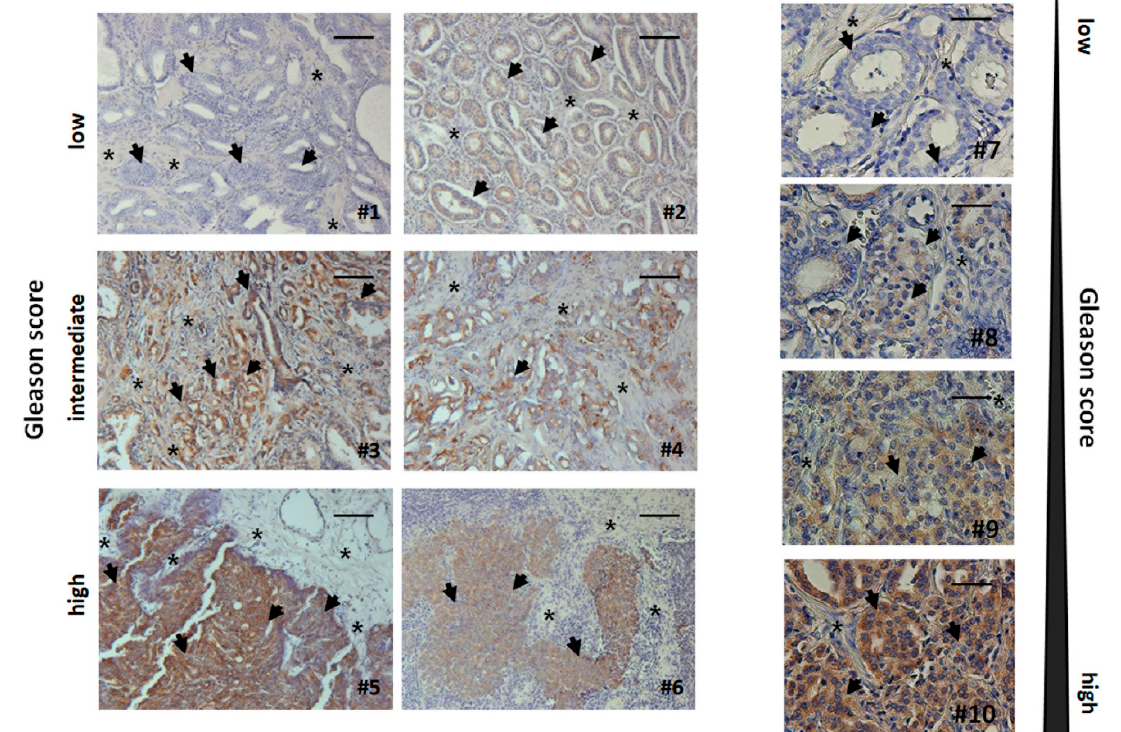
Figure 5. Immunohistochemical analysis of TRIAP1 expression levels in human prostate cancer tissues.